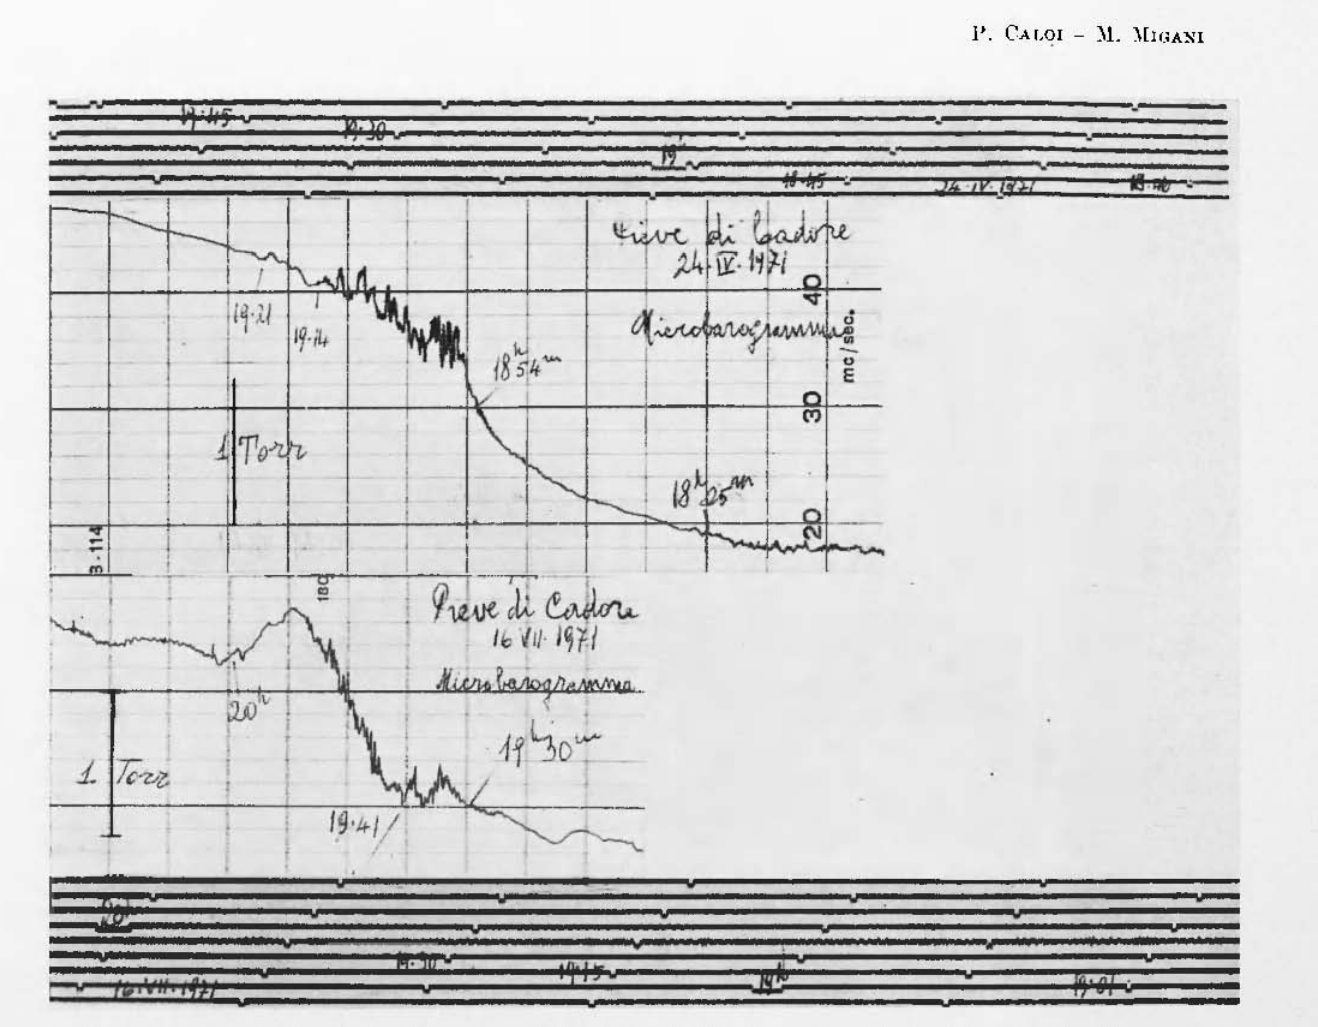
Fig. 10a - Lievi mierosismi sulla comp. Valle-Monie (ViI), in corrispondenza del passaggio di gruppi di rapide perturbazioni mierobariehe, sul lago tli Pieve di Cadore, dalle 19 h ca alle 19 b 20'" ca. l<'ig. 10b - Microsismi dalle 19 h 37 m ca alle 20 h 15rn ca, associati al passaggio sul lago di lievi f:l]Jitli, disturbi mierobal'ici, 811 pre;;8ione atmosferica in rapida a.s{~eHa. l microsismi iniziano seIllIJl"e qualche minuto dopo l'inizio dei diHtlll'bi microbal'ici () terminano alcuni minuti dopo il passaggio del nneleo perturbante. Fig. 10a - Light mieroseisl1ls OH the hill-valley component, corresponding to the passage of groups 01 rapid microbarie perturbations 011 the Lake of Pieve di Cadore, frolll alJOut 711 p.m. to about 811 p.In. Fig. 10/1 - MicroseisJlls from about 7h37m p.lll. t.o about 8hl5m p.m. associated to tho pa..~8Uge of light. rapid microbarie perturbations over the lake . .è\licroseisIlls always set iII a few minutes after the beginnillg of the mierobarie perfurbat.ions and end a few minuteR after the passage of the perturbing